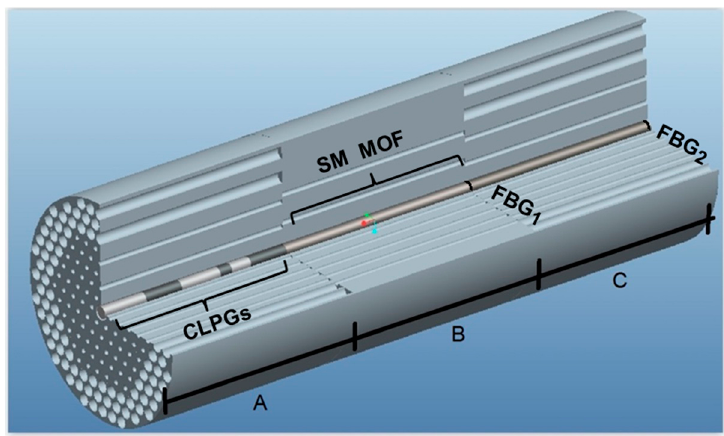
Figure 1. Sections of the temperature sensor: Section A: double cladding MOF with CLPGs inscribed within the core; Section B: single mode intermediate MOF; Section C: ytterbium-doped MOF laser cavity.